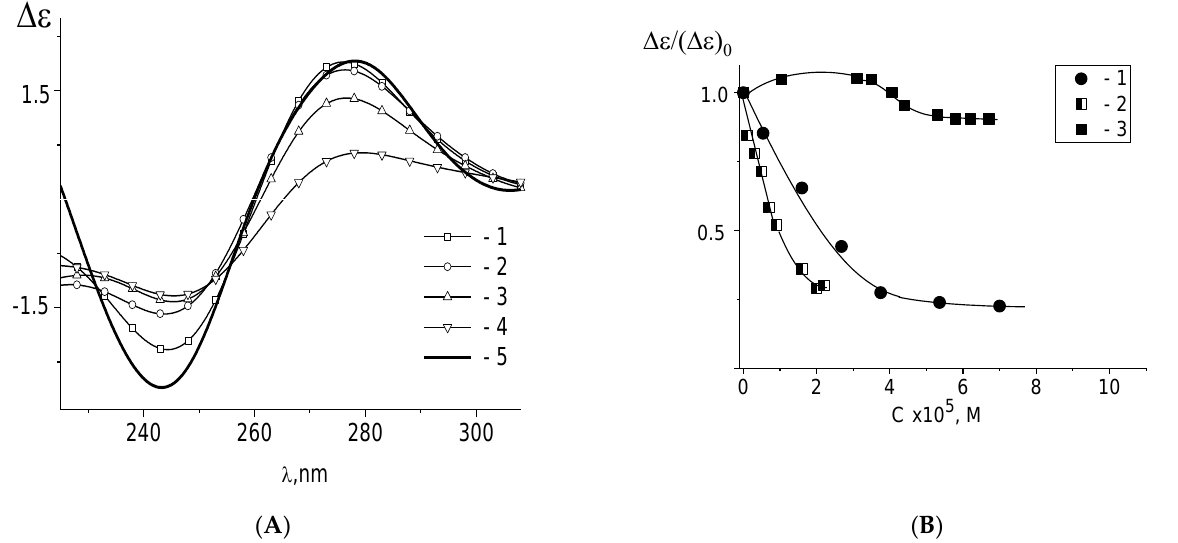
Figure 4. CD spectra of DNA in complexes with Pt3 in 0.005 M NaCl ( A ), and the dependence of the relative change in the amplitude of positive maximum of DNA CD spectra ( B ) on concentrations of Pt3 (1), Pt4 (2) and cis-DDP (3).